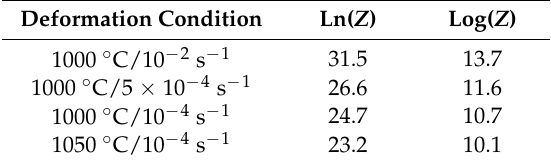
Table 1. The calculated values of Z under different deformation